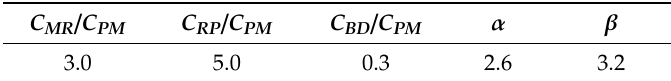
Table 4. Setting of parameters.